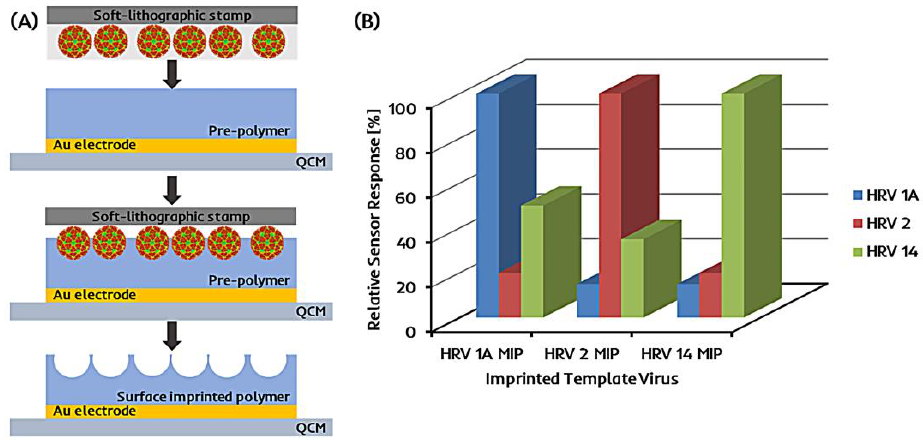
Figure 3. ( A ) A schematic representation of soft-lithography: A stamp of assembled virus particles is pressed onto the pre-polymer coated on a QCM electrode. After polymerization, the stamp is removed and the template is washed away to obtain the surface imprinted synthetic antibodies; ( B ) Relative sensor response of different human rhinovirus (HRV) serotype-imprinted polymers towards different strains of HRV. It is evident that each sub-type of HRV is preferentially identified by the respective MIP surface. Figure 3B is reproduced with permission from Jenik et al. [66]. surface. Figure 3B is reproduced with permission from Jenik et al. [66]. Copyright by the American Copyright by the American Chemical Society, 2009. Chemical Society,